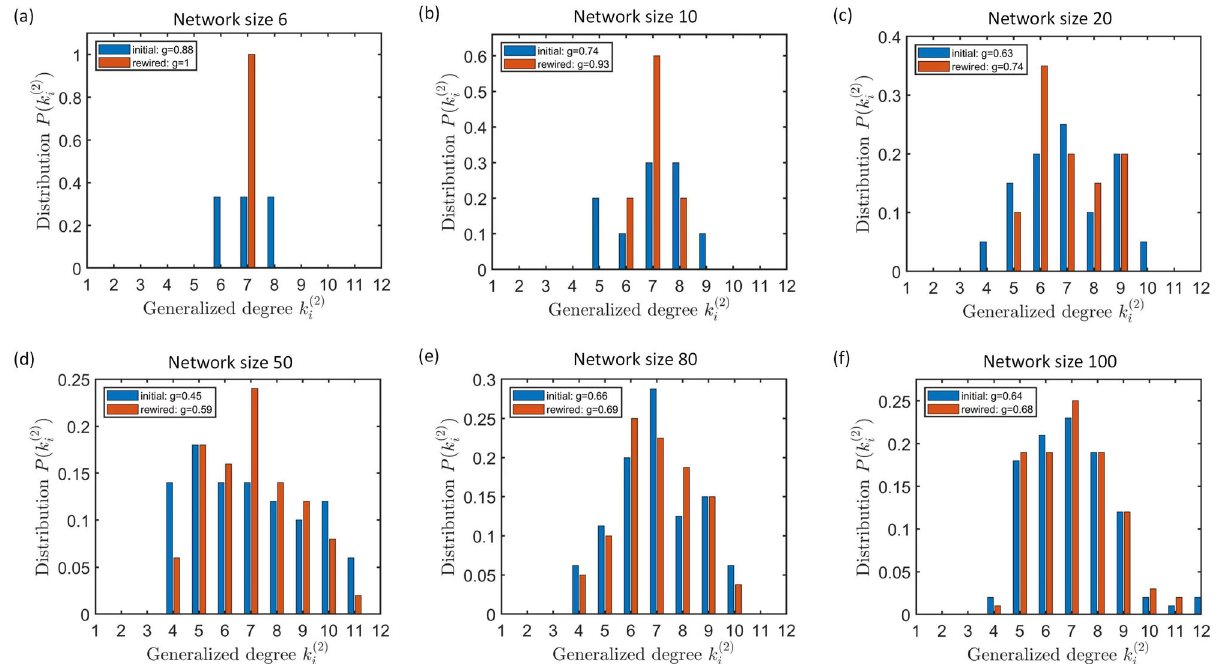
Fig. 4 Statistical properties of the rewired undirected network after optimizing synchronizability. The distribution of the generalized nodes' degree Eq. (8) for networks with 2-hyperlink interactions under various sizes: a 6, b 10, c 20, d 50, e 80, f 100. The generalized nodes' degree distribution shows that the more synchronizable network tends to be homogeneous. Correspondingly, the homogeneity parameter 43 – 46 g given by Eq. (16) is bigger for the rewired network, indicating more homogeneous nodes' degrees. The property of the more synchronizable 2-hyperlink interactions is consistent with 1-hyperlink interactions, where nodes also tend to be homogeneous in degree 26